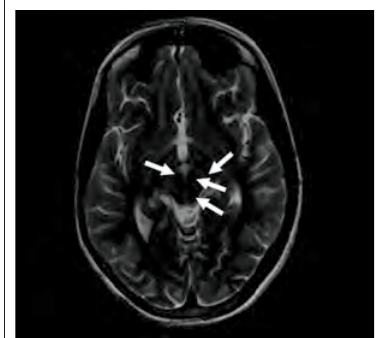
Fig. 1. Axial T2-weighted MRI of the brain at the level of the midbrain showing the characteristic ‘face of the giant panda’ sign, with normal red nuclei and substantia nigra (pars reticulata) against a background of hyperintensity in the tegmentum, as well as hypointensity of the superior colliculi.